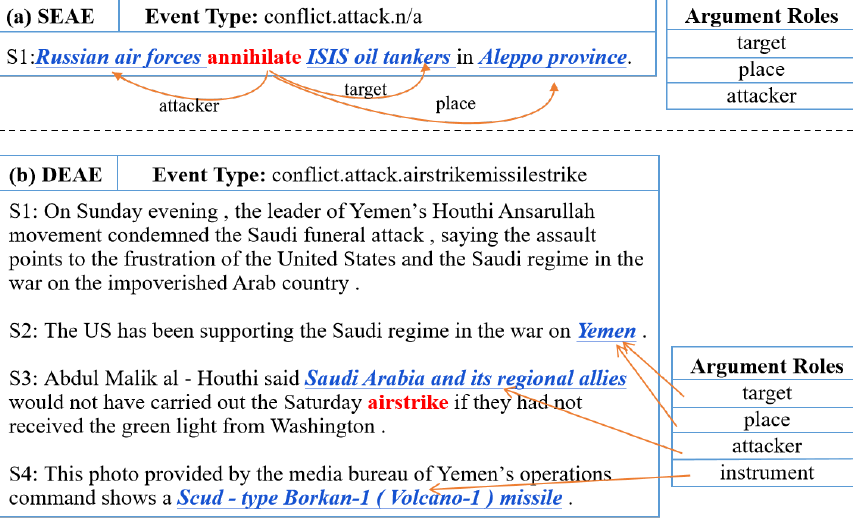
Figure 1. Illustrations of SEAE and DEAE. ( a ) An example of SEAE, where event arguments are extracted from a sentence. ( b ) An example of DEAE, where there are arguments scattering and overlapping. The trigger words are marked in red bold text, and the arguments are marked in blue italicized text with